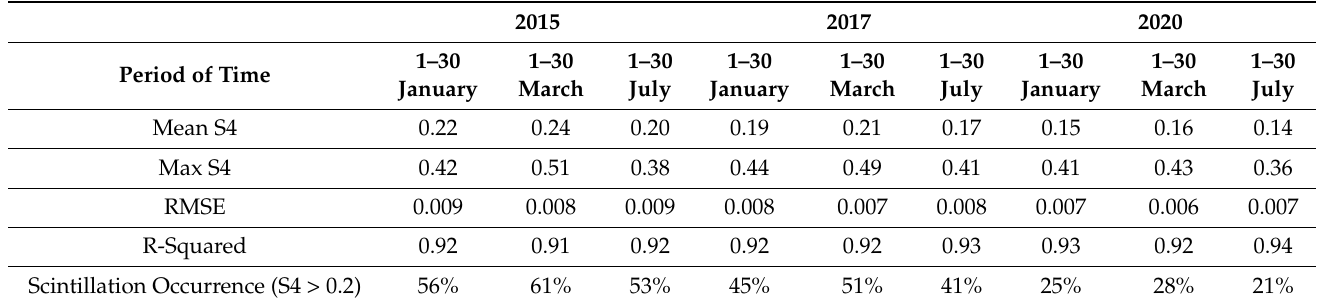
Table 1. The difference between observed and GANN-modeled S4 during the 30 days for January, March, and June in